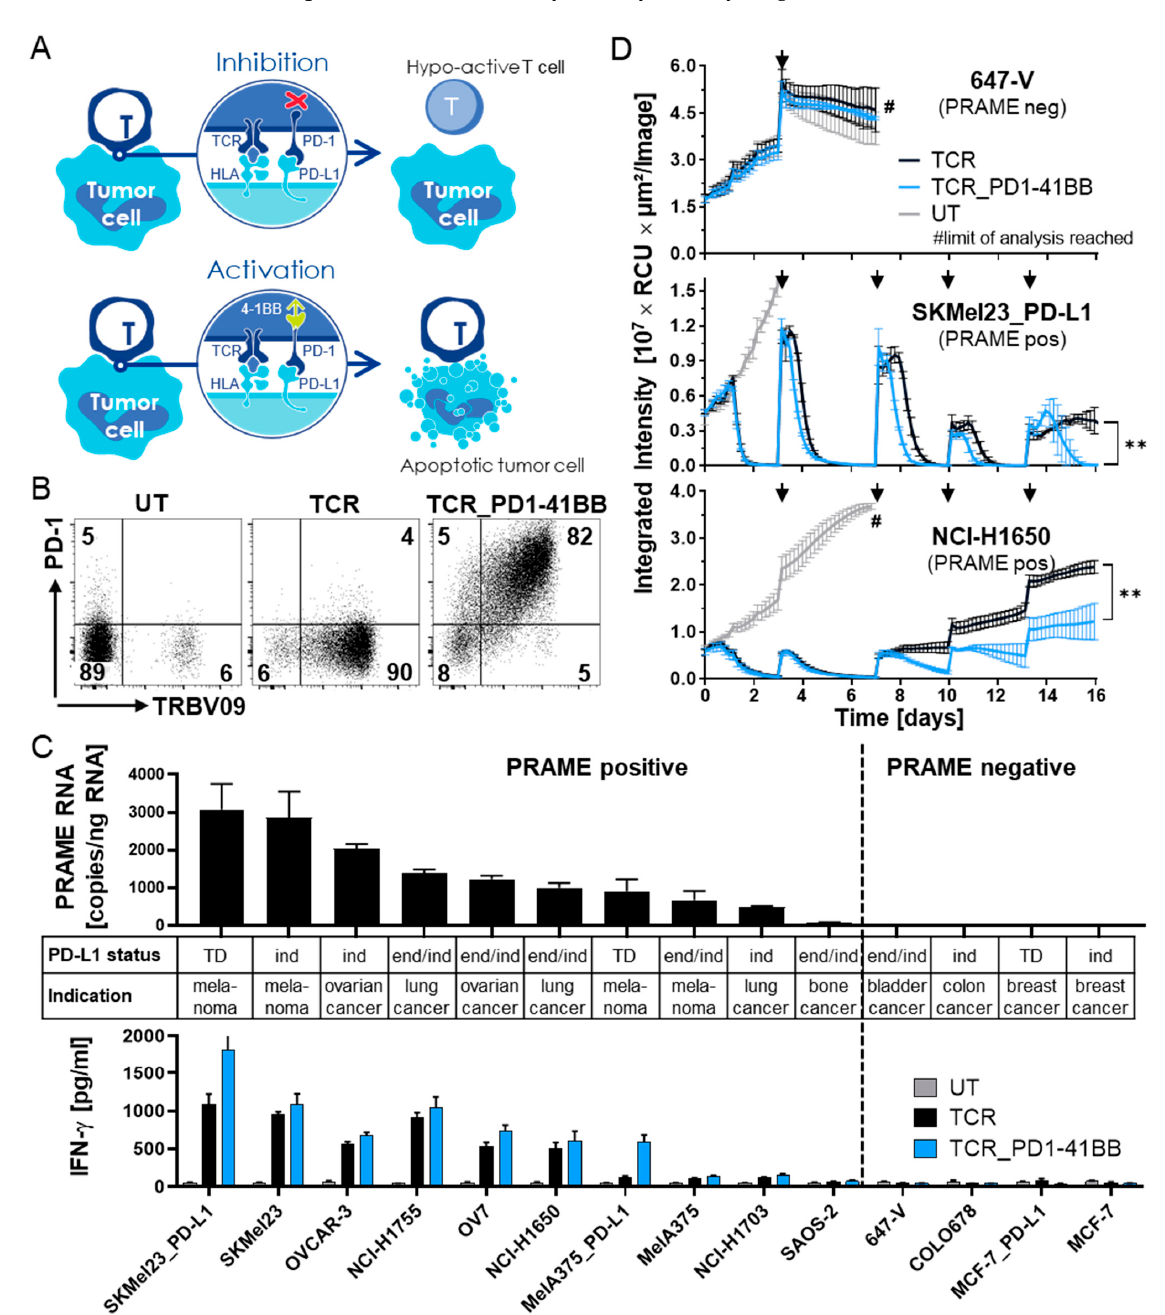
3.2. Chimeric PD1-41BB Co-Stimulatory Receptor Improves Effector Functions of TCR-Ts To overcome the inhibitory effect of the PD-1/PD-L1 axis, the PRAME-specific TCR- 027-004 was co-expressed with a chimeric PD1-41BB receptor in TCR-Ts, whereby PD-L1 interaction with the chimeric receptor should turn the inhibitory signal into additional T-cell co-stimulation (Figure 2A). CD8+ TCR-Ts with TCR-027-004 alone (TCR) or combined with PD1-41BB (TCR_PD1-41BB) were generated, and surface expression of one or both receptors was confirmed by flow cytometry (Figure 2B).